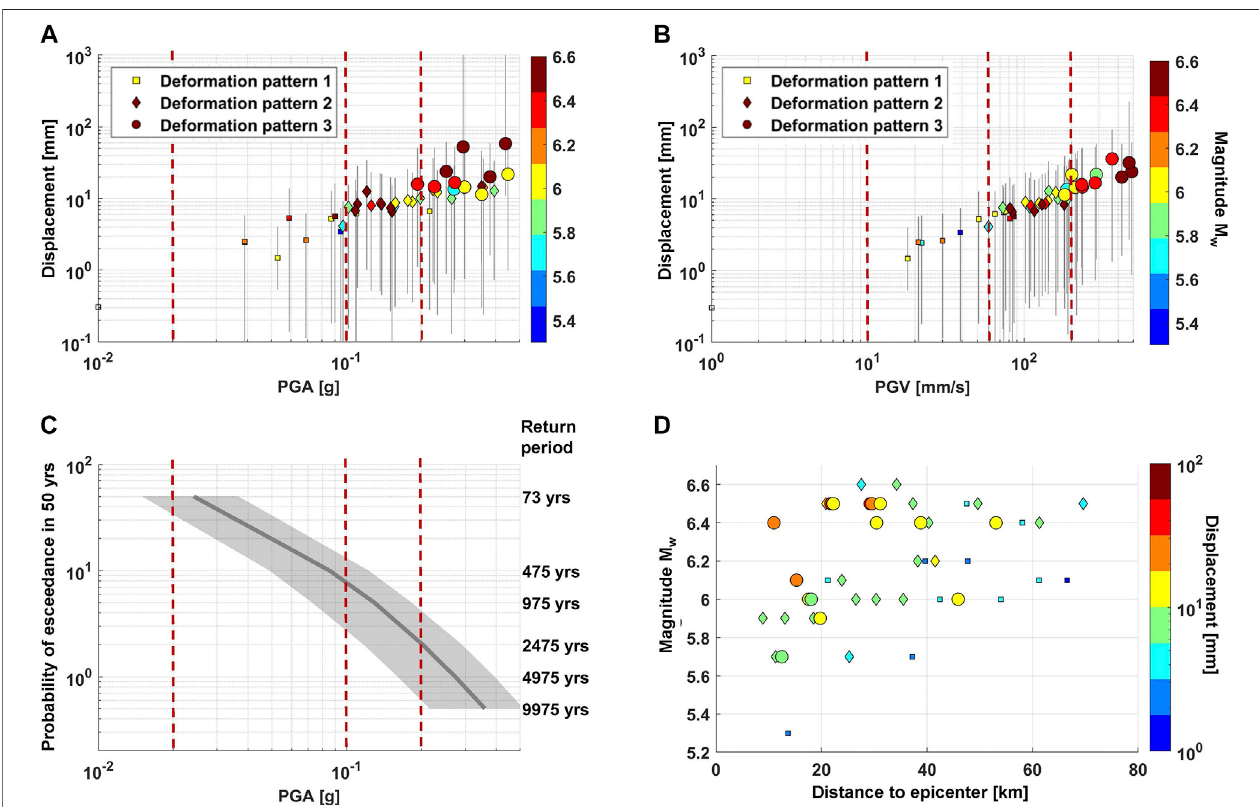
FIGURE 9 | Deformation patterns and their occurrence depending on peak ground acceleration (PGA), peak ground velocity (PGV) and their relation to return period, distance to epicenter and magnitude; (A) Displacement (median) around the cavern of the collapsed tunnel below Dreispitz for different deformation patterns depending on the peak ground acceleration (PGA) respectively; (B) peak ground velocity (PGV); grey bars represent the range between the minimum and the maximum displacement; (C) Hazard curves for PGA (downloaded from the EFEHR (European Facilities for Earthquake Hazard and Risk) website http://efehr.org) based on the Swiss seismic hazard model (Wiemer et al., 2015); (D) representation of the earthquake scenarios in magnitudes and distance, with the associated median displacement at the site Mitholz and the resulting deformation pattern; red dotted lines represent the threshold values for the three deformation patterns.